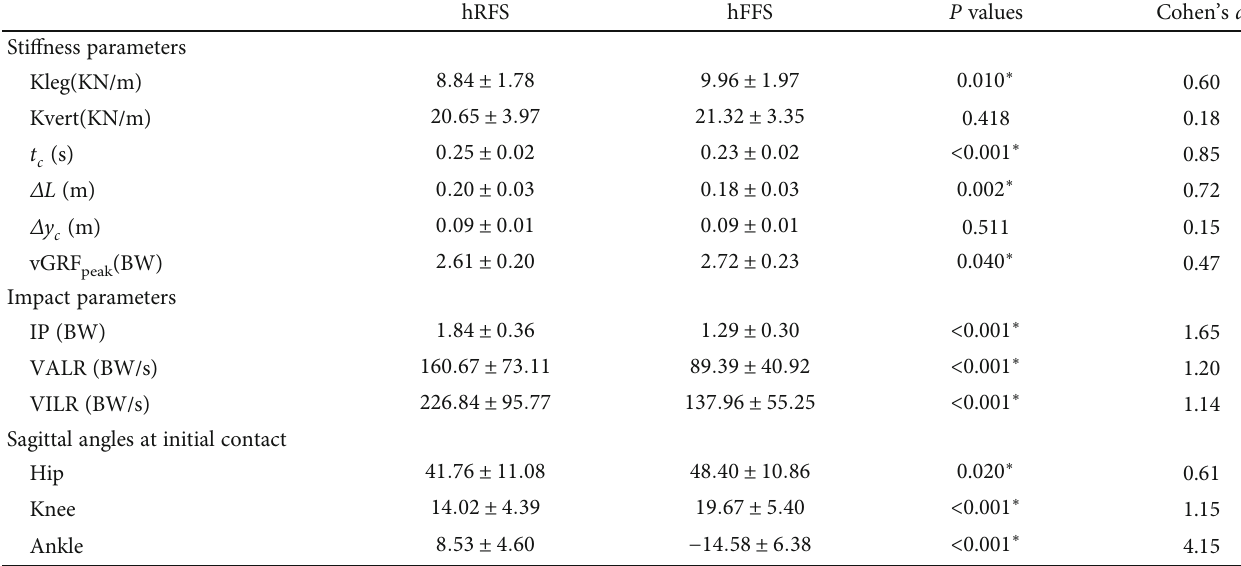
Table 1: Comparison of leg and vertical sti ff ness, impact parameters, and sagittal angles at initial contact between runners with hRFS and hFFS ( mean ± standard deviation